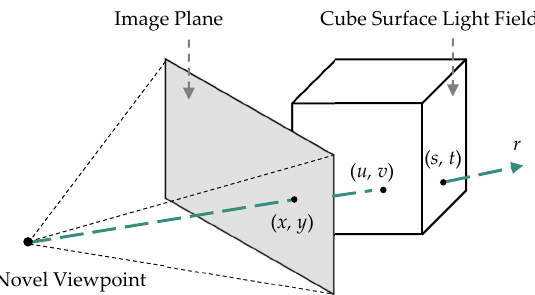
Figure 5. Relationship between a desired novel viewpoint, pixel in image plane and the cube surface light field in the